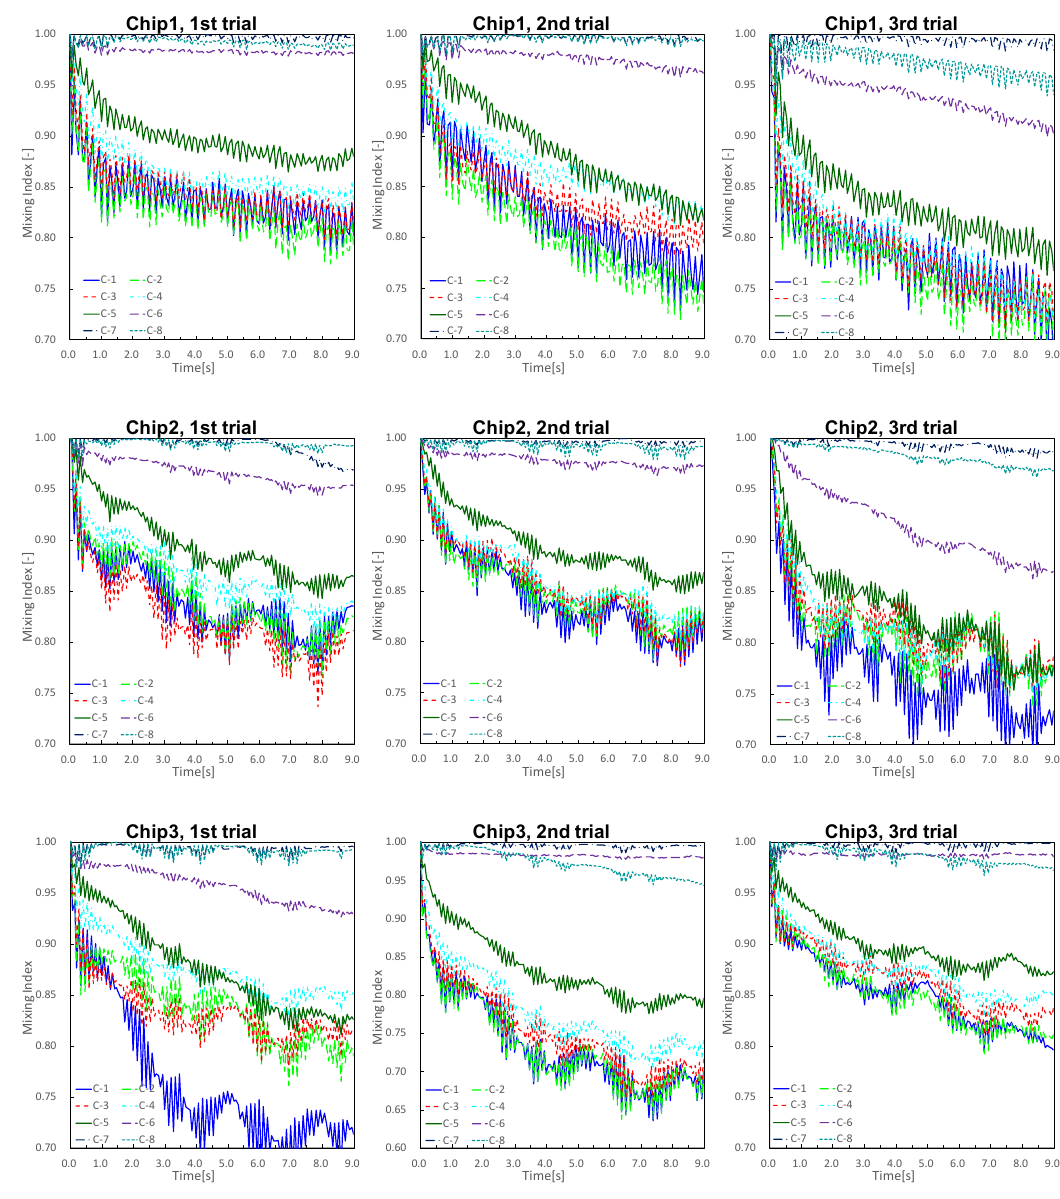
Figure A7. Time variation in mixing index until 9 s after the application of air